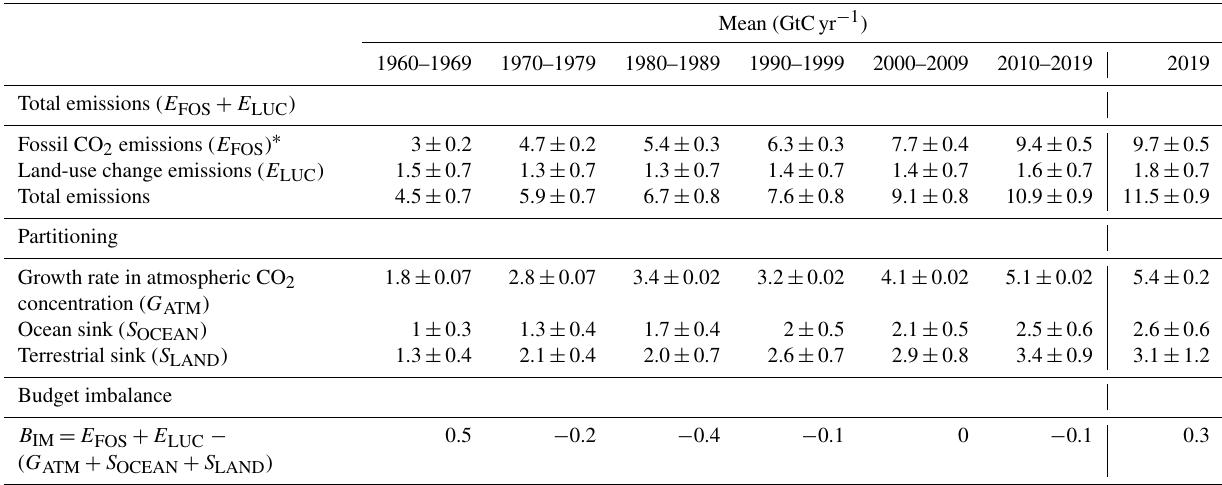
Table 6. Decadal mean in the five components of the anthropogenic CO 2 budget for different periods, and last year available. All values are in GtCyr − 1 , and uncertainties are reported as ± 1 σ . The table also shows the budget imbalance ( B IM ), which provides a measure of the discrepancies among the nearly independent estimates and has an uncertainty exceeding ± 1GtCyr − 1 . A positive imbalance means the emissions are overestimated and/or the sinks are too small. All values are rounded to the nearest 0.1GtC and therefore columns do not necessarily add to